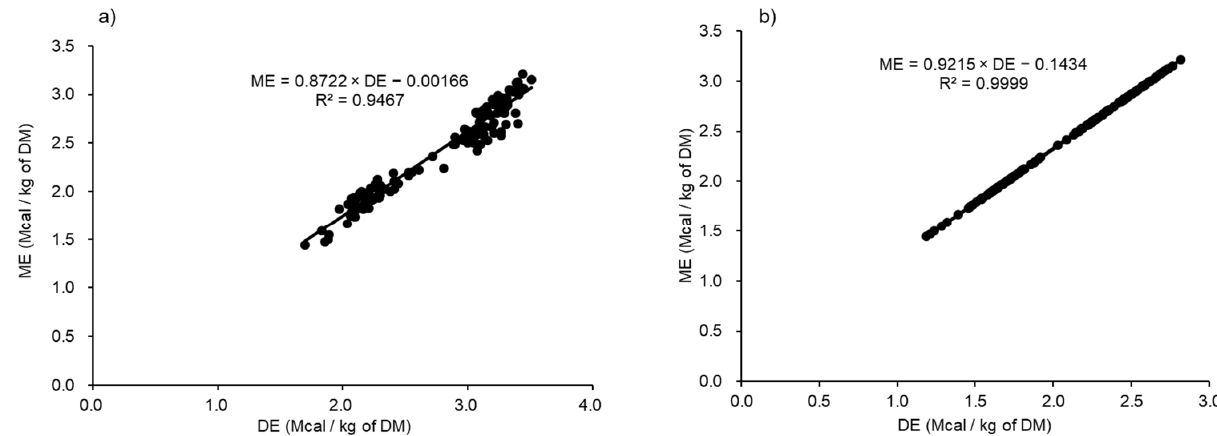
Figure 1. Relationship between the digestible energy (DE) and metabolizable energy (ME) concentrations of the overall data unadjusted ( a ) and adjusted for random differences in intercepts among the citations ( b ) DM; dry matter.